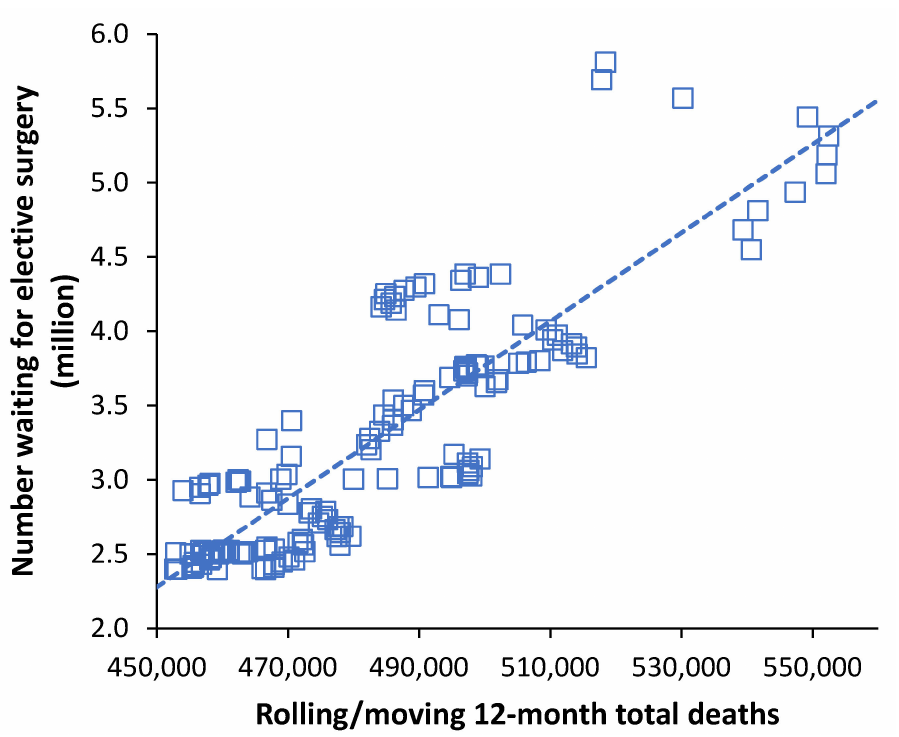
Figure 6. Rolling 12-month total persons waiting for elective surgery in England versus a rolling 12-month total of deaths. Data on the number of persons on the elective waiting list are from NHS England